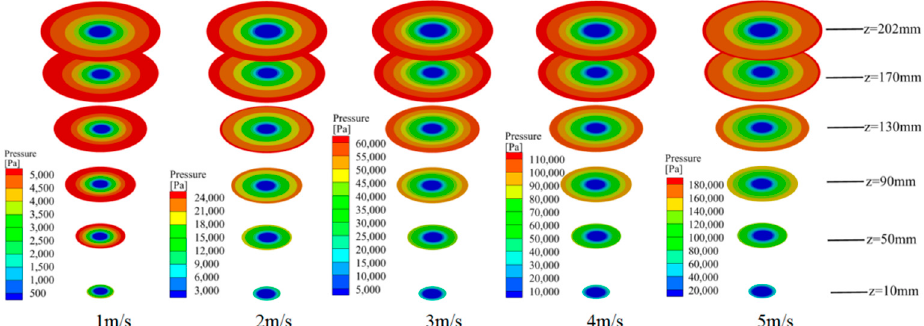
Figure 3. Schematic of axial characteristic section of the hydrocyclone.